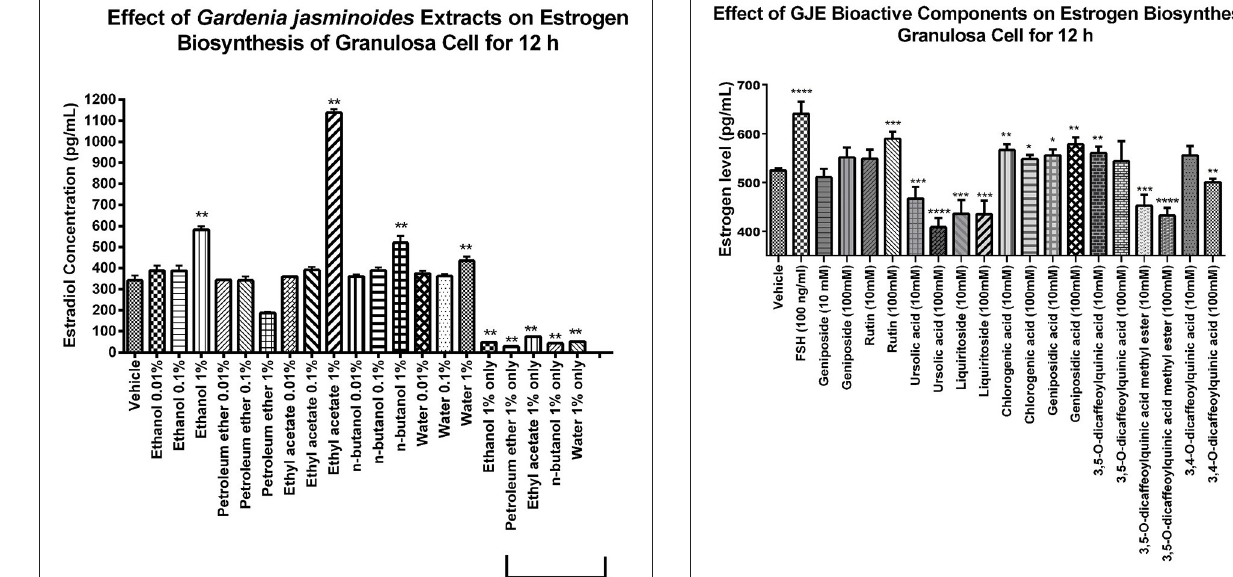
FIGURE 9 | Identification of the GJE-EA derived bioactive components with estrogen stimulating effect using phenotypic screening. Effects of GJE components on production of estrogen in granulosa cells after treatment for 12h was determined by estradiol assay. Each value represents mean ±